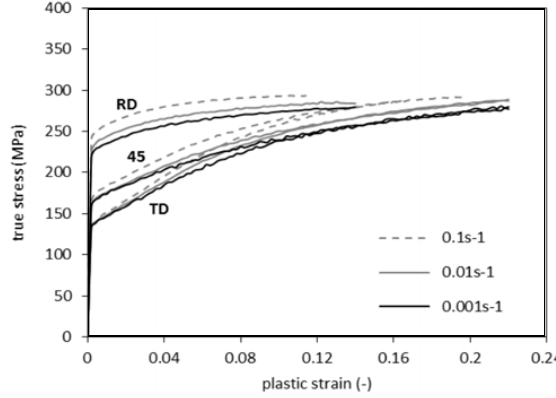
Fig. 7. E ff ect of orientation on work hardening rate for ZEK100 sheet at a strain rate of 0 . 1s − 1 .